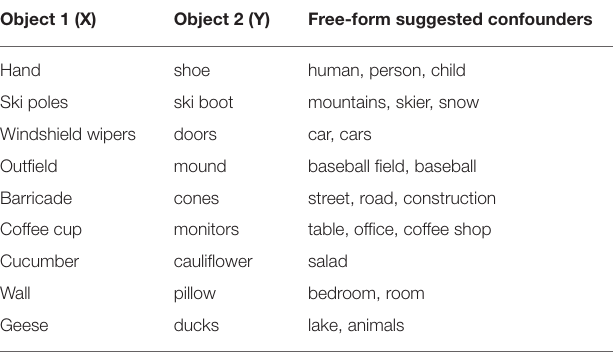
TABLE 3 | Subset of free-from confounders suggested by